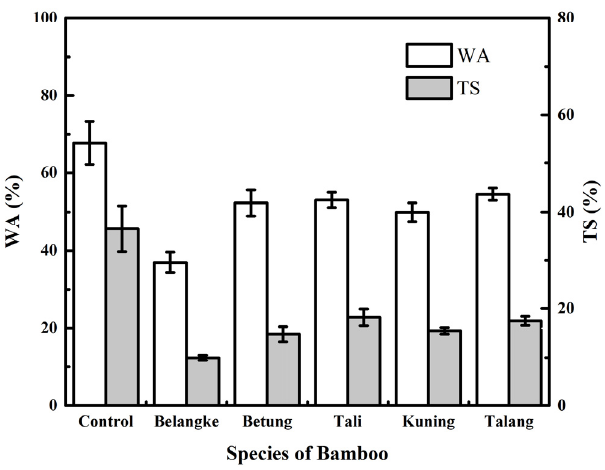
Figure 3. Water absorption (WA) and thickness swelling (TS) of particleboards.